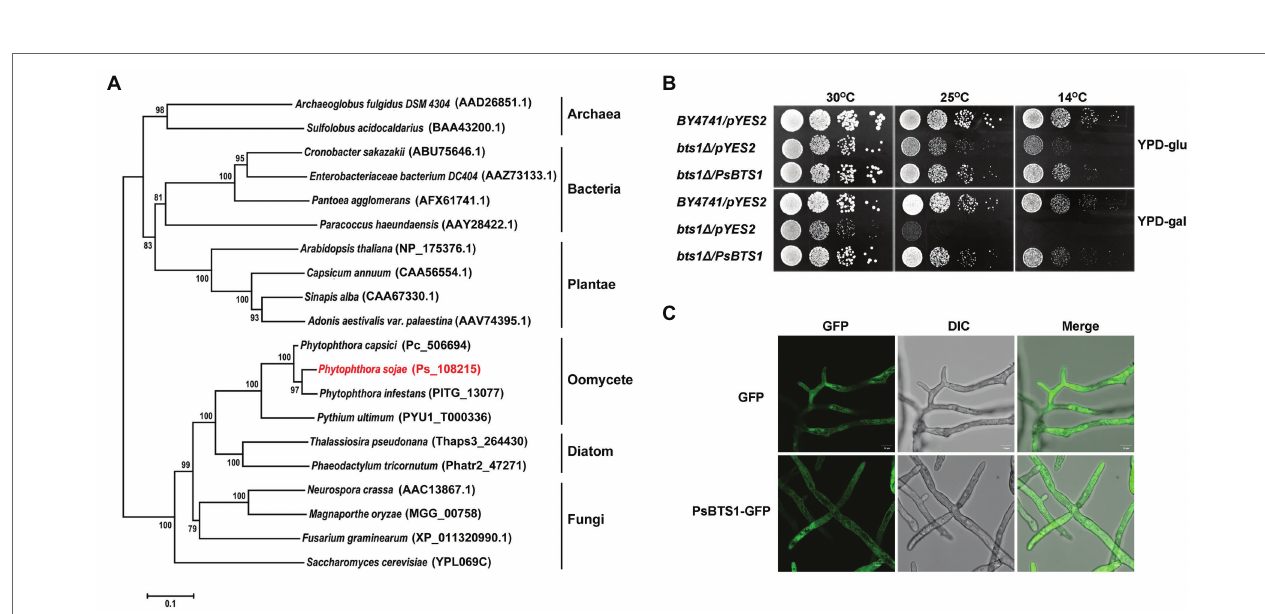
FIGURE 3 | Lovastatin treatment led to reduced virulence of P. sojae . Zoospore suspensions pretreated with various concentrations (0, 20, 40, and 80 μ g/ml) of lovastatin were inoculated into hypocotyls of soybean cultivar Hefeng 47. (A) Photos and (B) lesion lengths were taken at 48 hpi. (C) The germinated cysts of untreated zoospores (CK) were observed on soybean epidermal cells at 12 and 24 hpi; lovastatin (80 μ g/ml)-treated zoospores had not germinated at 12 or 24 hpi; and a and b indicate significant differences ( p < 0.05). Bar: 25 μ m.